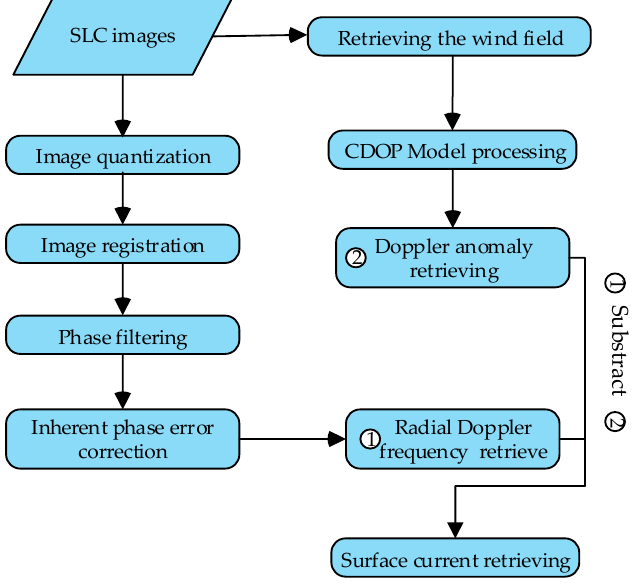
Figure 5. Data processing flow.